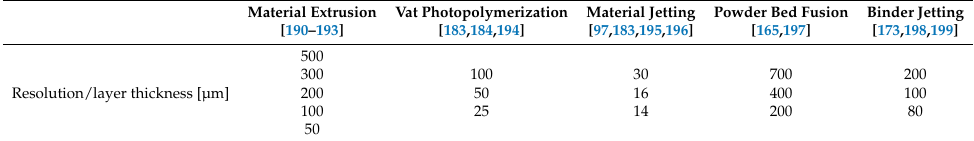
Table 4. Resolutions/layer thickness available depending on the 3D printing